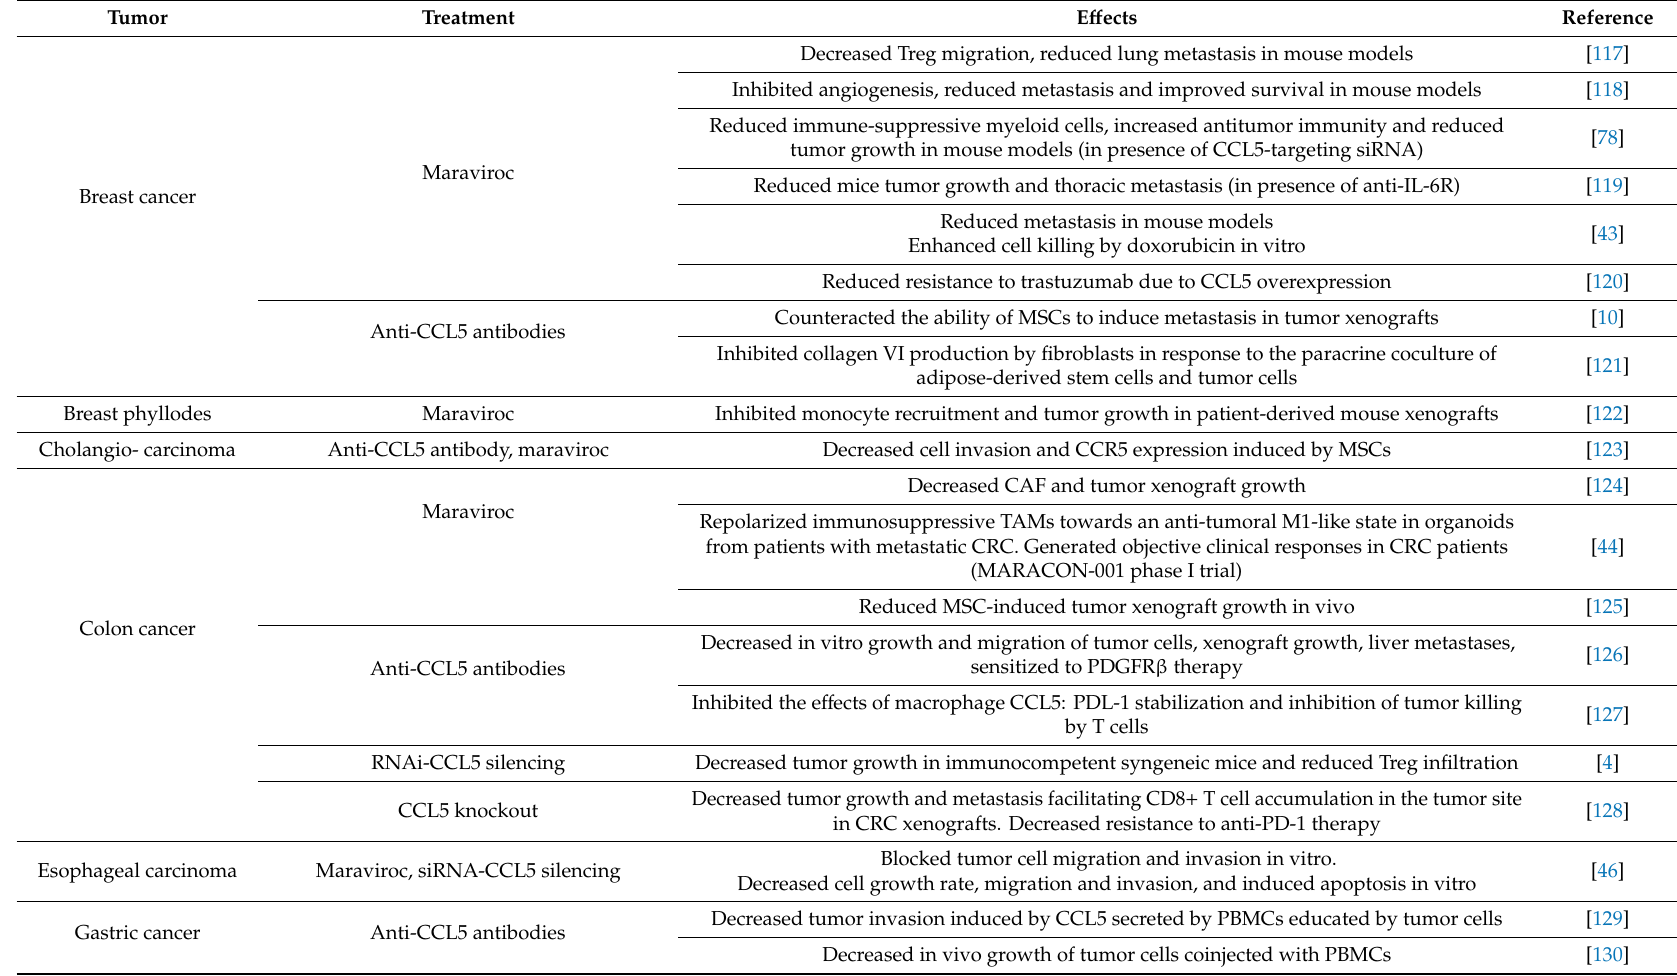
Table 2. E ff ects of disrupting the CCL5 / CCR5 axis in solid